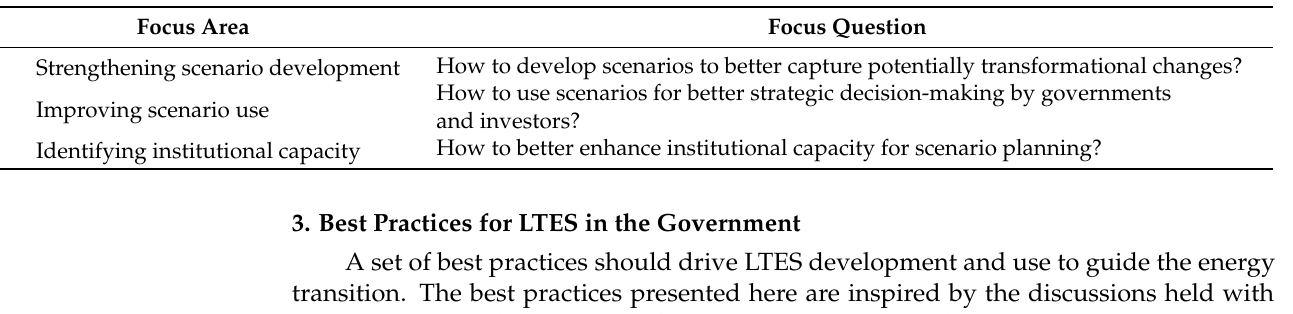
Table 1. Focus areas of IRENA’s LTES network and focus